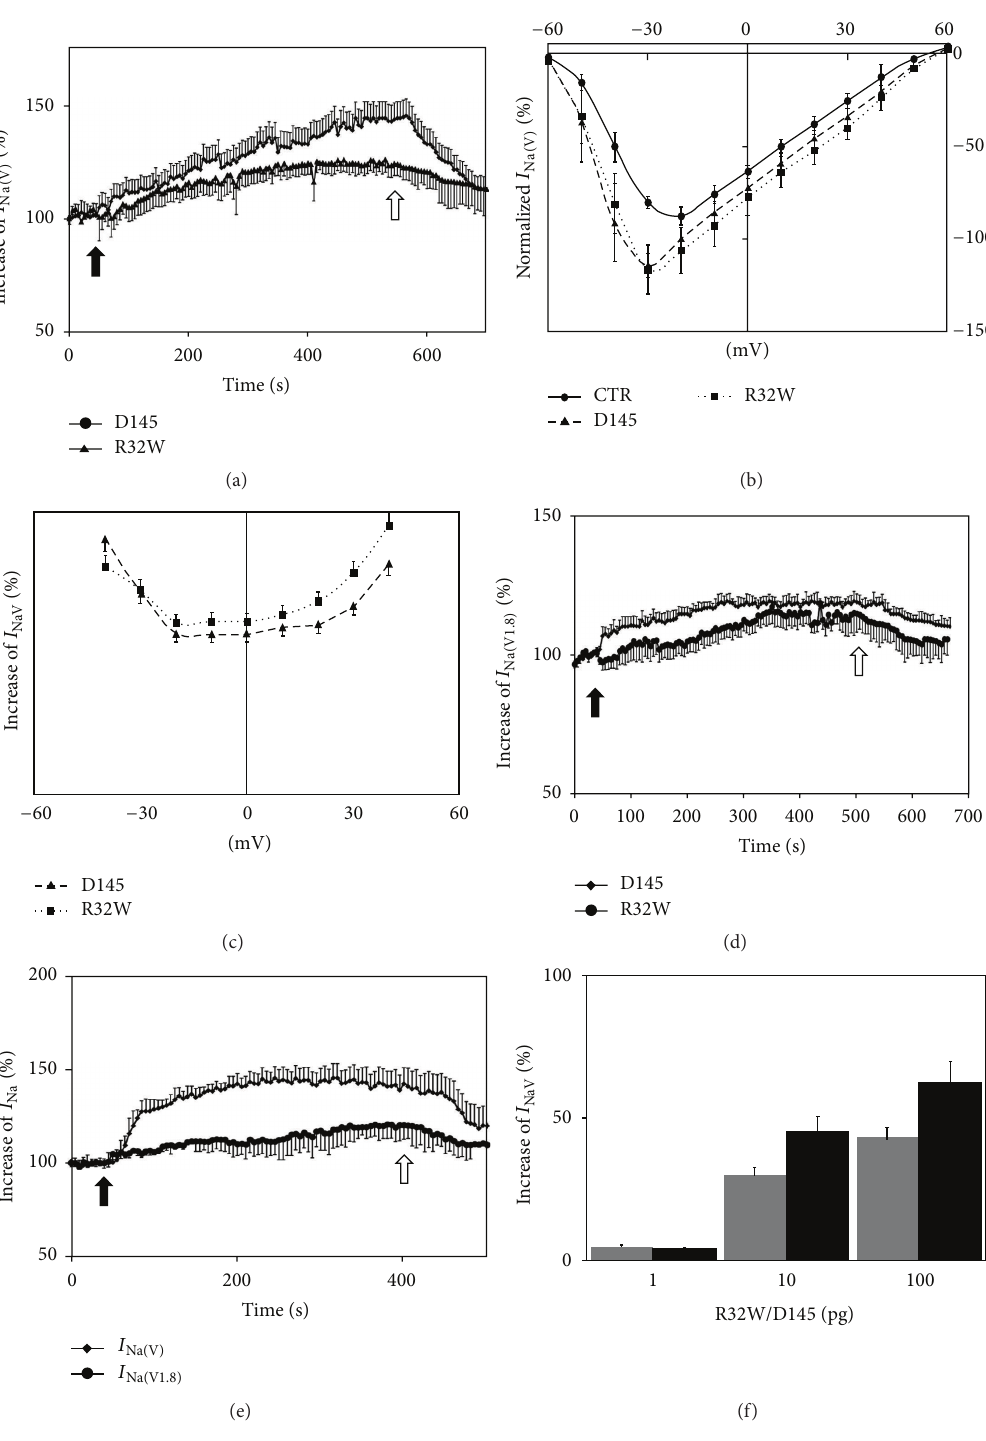
Figure 2: Characterization of R32W and D145 effects on 𝐼 Na ( V ) and 𝐼 Na ( V 1.8) currents. (a) Time course of normalized 𝐼 Na ( V ) during repetitive depolarization from the holding potential to 0mV before and after application of 10pg R32W or 10pg D145 (black arrow: time of application; white arrow: washout). (b) 𝐼𝑉 -curve of 𝐼 Na ( V ) (black: control conditions; speckled line: after application of 10 pg R32W; dashed line: after application of 10pg D145). Cells were depolarized to a variety of potentials ( − 60 to 60 mV) from a holding potential of –80 mV at increments of 10mV to elicit 𝐼 Na ( V ) . (c) Voltage-dependent reduction of 𝐼 Na ( V ) after administration of 10pg R32W or 10pg D145. (d) Time course of normalized 𝐼 Na ( V 1.8) during repetitive depolarization from the holding potential to 0mV before and after application of 100pg R32W or 100pg D145 (black arrow: time of application; white arrow: washout). (e) Time course of normalized 𝐼 Na ( V ) and 𝐼 Na ( V 1.8) during repetitive depolarization from the holding potential to 0 mV before and after application of 10 pg R32W and 10 pg D145 (black arrow: time of application; white arrow: washout). (f) R32W and D145 dose-dependent increase in 𝐼 Na ( V )